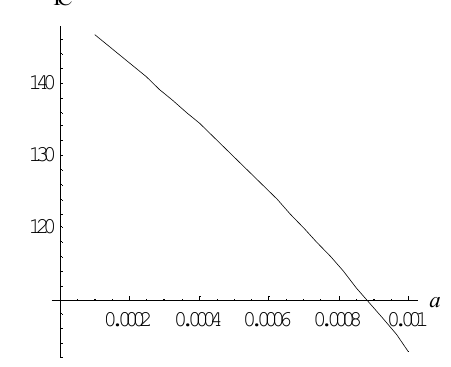
Fig. 5(a) The effect of parameter a on the total cost in the crisp model